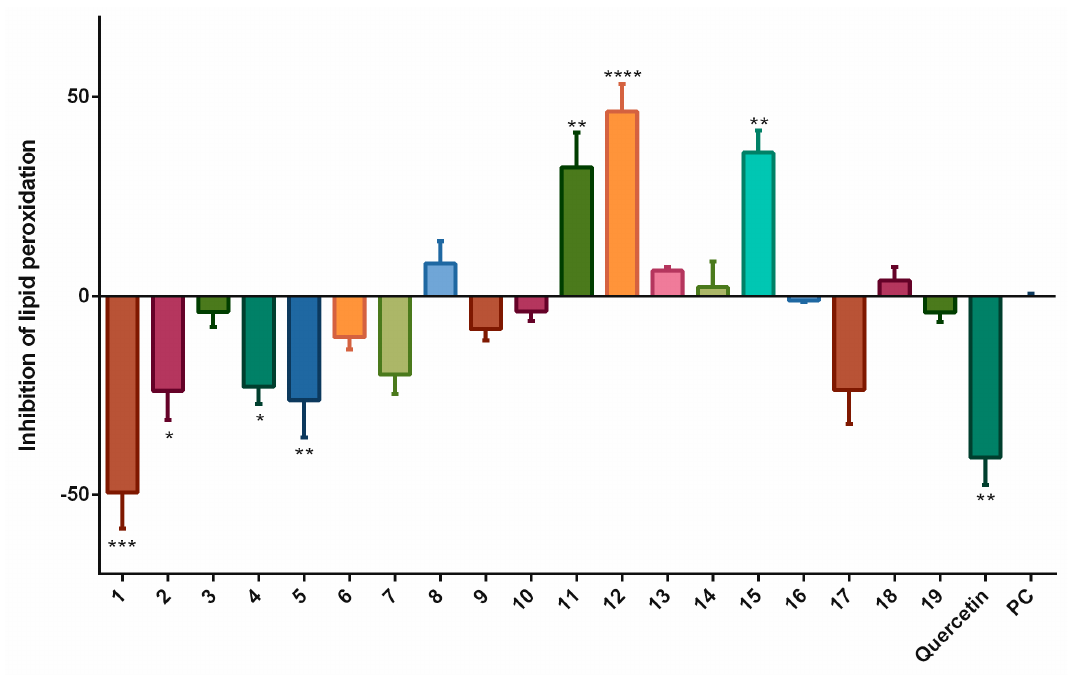
Figure 1. The effects of stilbenoids 1–19 (at a concentration of 15 μ M) on the lipid peroxidation of linoleic acid caused by 2,2´-azobis(2-amidinopropane)dihydrochloride (AAPH), and measured as the production of malondialdehyde (MDA) using the thiobarbituric acid reactive substances (TBARS) assay. Quercetin was used as a standard (15 µ M) and AAPH alone served as the positive control (PC). The negative control (NC) contained linoleic acid alone, and thus, no lipid peroxidation occurred. The effects of the vehicle were subtracted from that of each stilbenoid. * = p < 0.05; ** = p < 0.01; *** = p < 0.001; and **** = p < 0.0001.